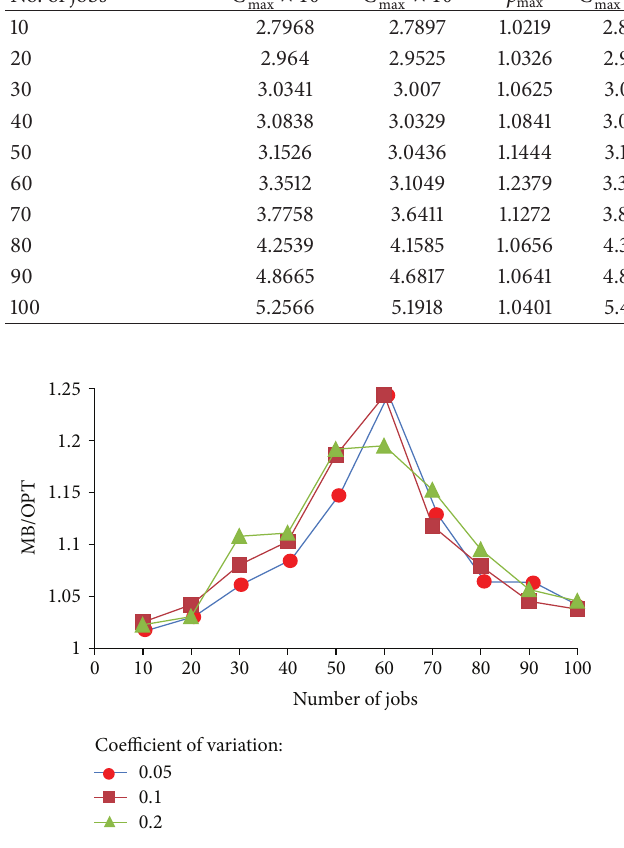
Figure 7: 𝜌 versus the number of jobs and the coefficient of